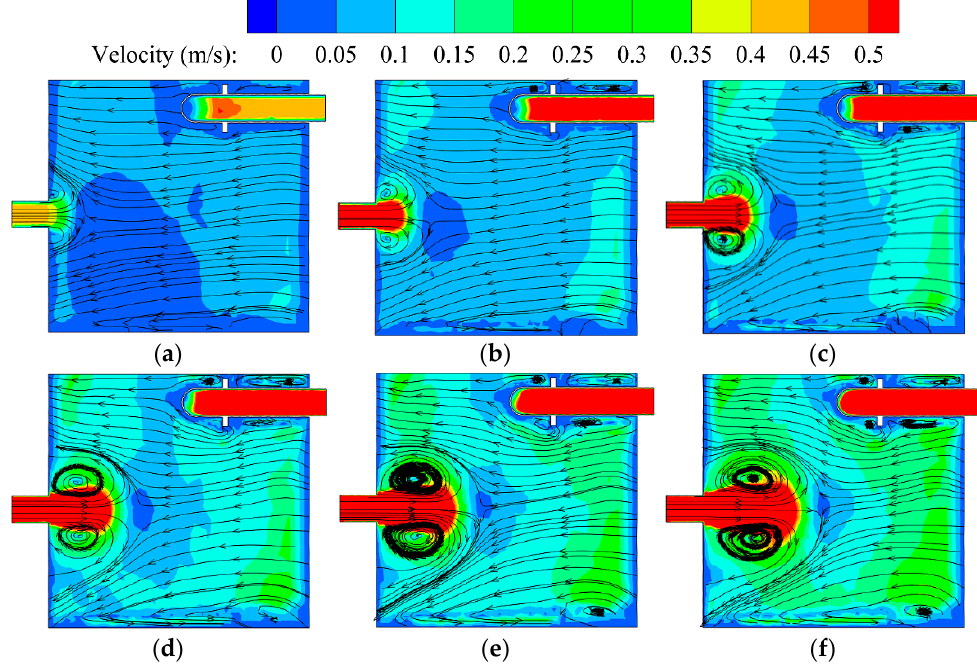
Figure 10. Cross-section A4 velocity and streamline distribution. ( a ) 0.33 Q d , ( b ) 0.67 Q d , ( c ) 1.00 Q d , ( d ) 1.33 Q d , ( e ) 1.67 Q d , and ( f ) 2.00 Q d .